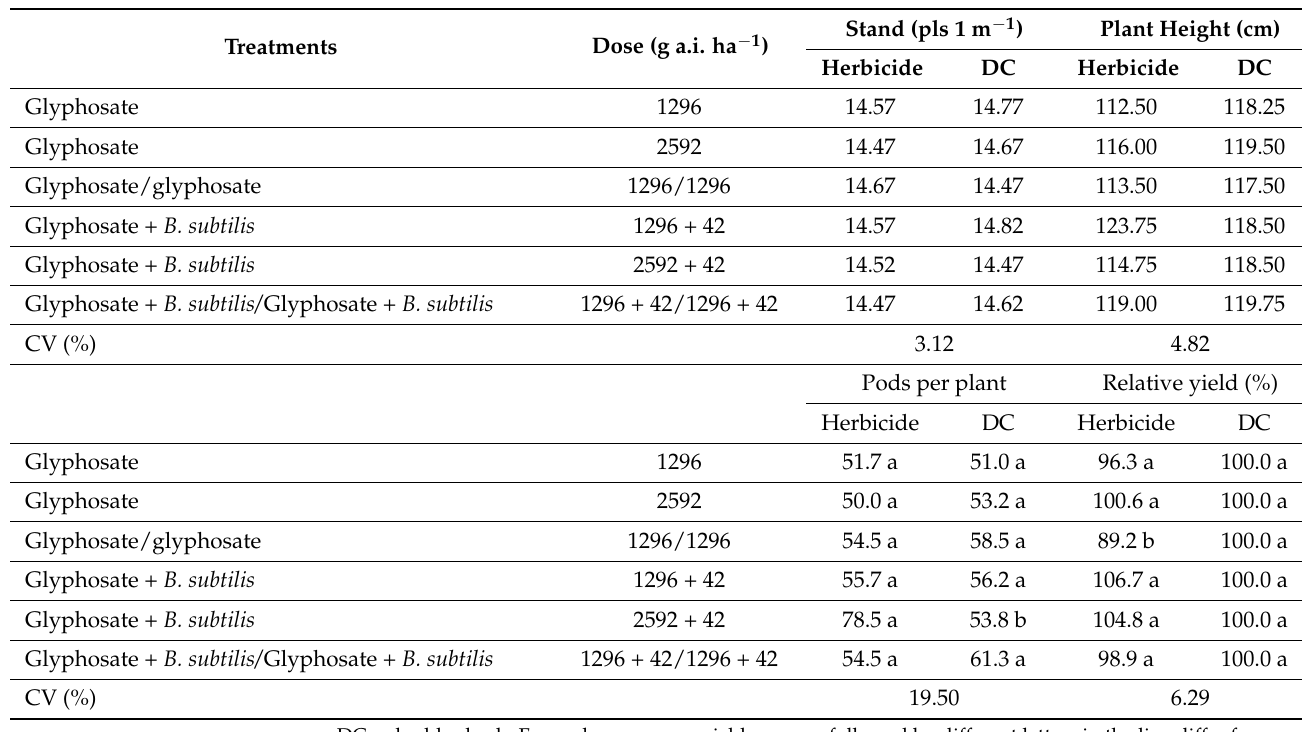
from each other by the F Test ( p ≤ 0.05).